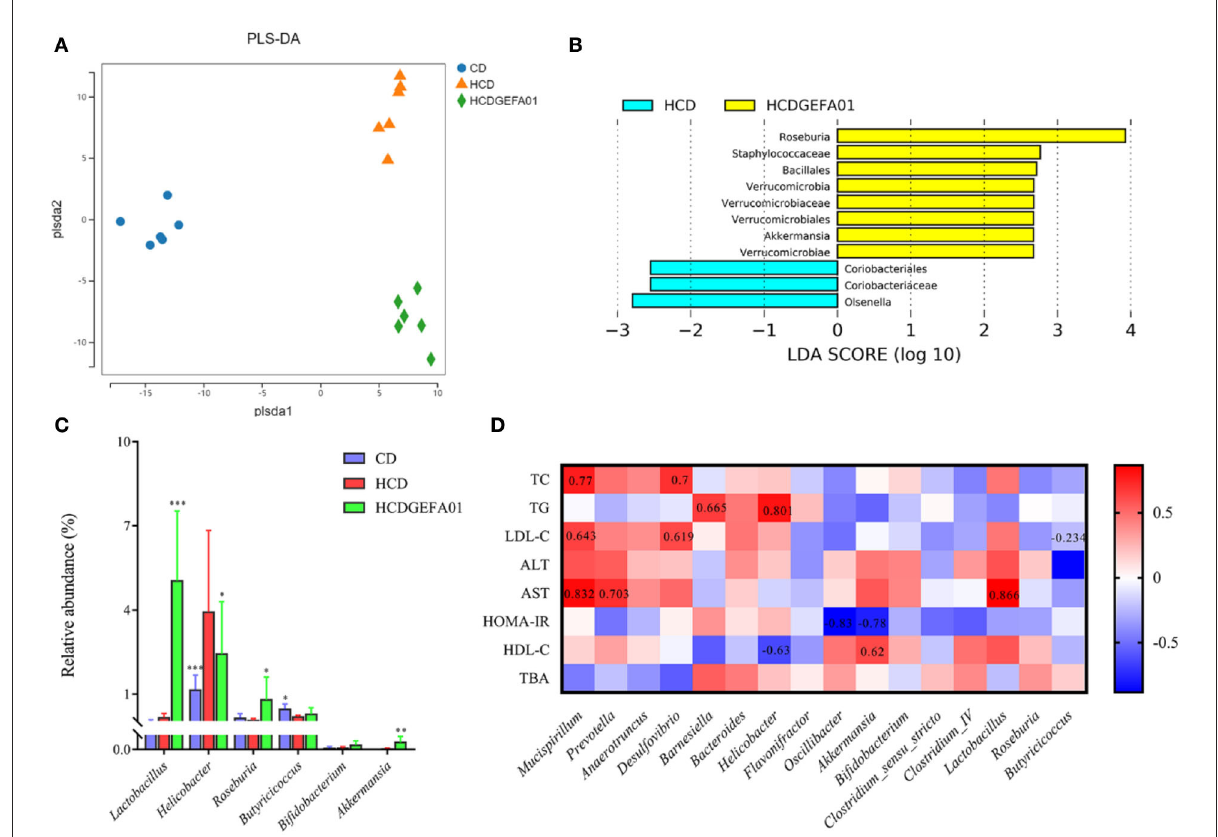
FIGURE8 A correlation between perturbed gut bacteria genera and metabolic disorder-related indices. (A) partial least squares discriminant analysis (PLS-DA) plot of gut microbiota; (B) linear discriminant analysis effect size (LEfSe) analyzed the most differential taxons between the HCD and HCDGEFA01 groups; (C) Relative abundance at the genus level, including Lactobacillus , Helicobacter , Roseburia , Butyricicoccus , Bifidobacterium , and Akkermansia . (D) Spearman’s correlation analysis was calculated between 16 identified bacteria genera and cholesterol metabolism traits. Data were expressed as mean ± SEM: n = 6 animals per group; * p < 0.05, ** p < 0.01, *** p < 0.001, all groups were compared to the HCD group. The red and blue blocks represent positive and negative correlations,